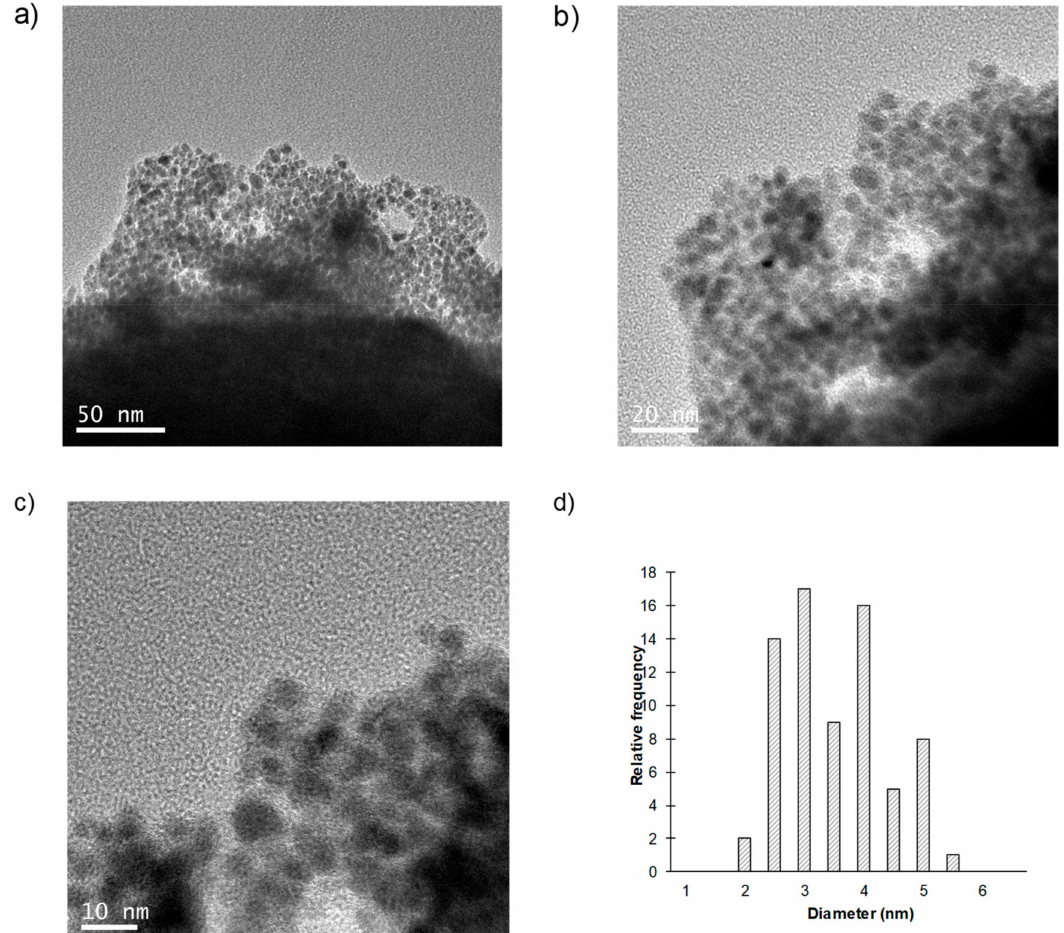
Figure 4. Characterization of GTL σ -A193Cp-PdNPs bionanohybrid. ( a – c ) transmission electron microscopy (TEM) and high resolution TEM (HRTEM) micrographs. ( d ) Pd NPs size